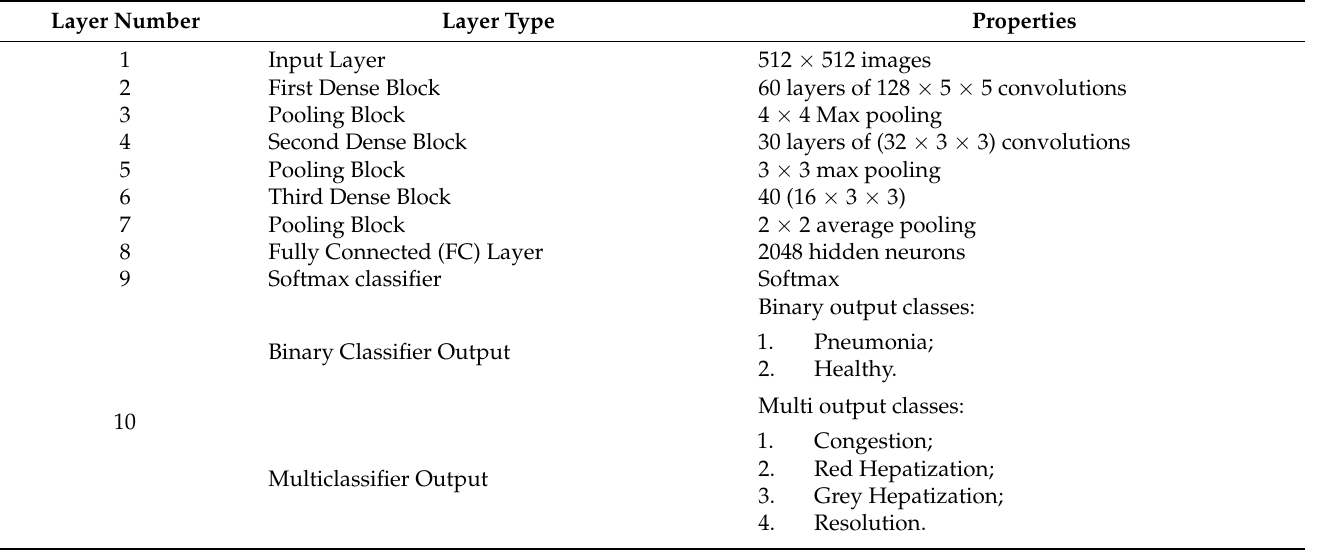
Figure 1 . The architecture of the BoxENet .